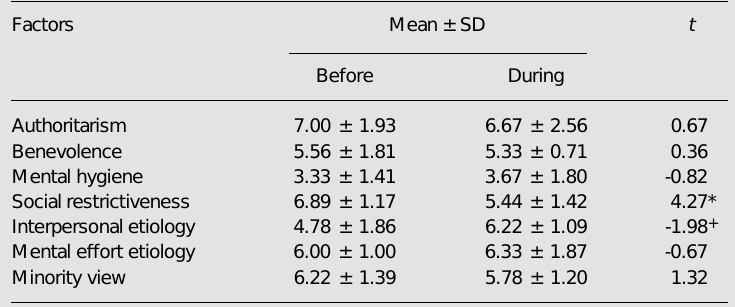
Figure 1. Proportion of interac- tion time between inpatients and nursing aides during the videotaped activities. Lines show the results for each nurs- ing aide and squares the aver- age before (open squares) and during (filled squares) the IOSPI application. *P<0.05 vs before IOSPI application (Student t - test). During